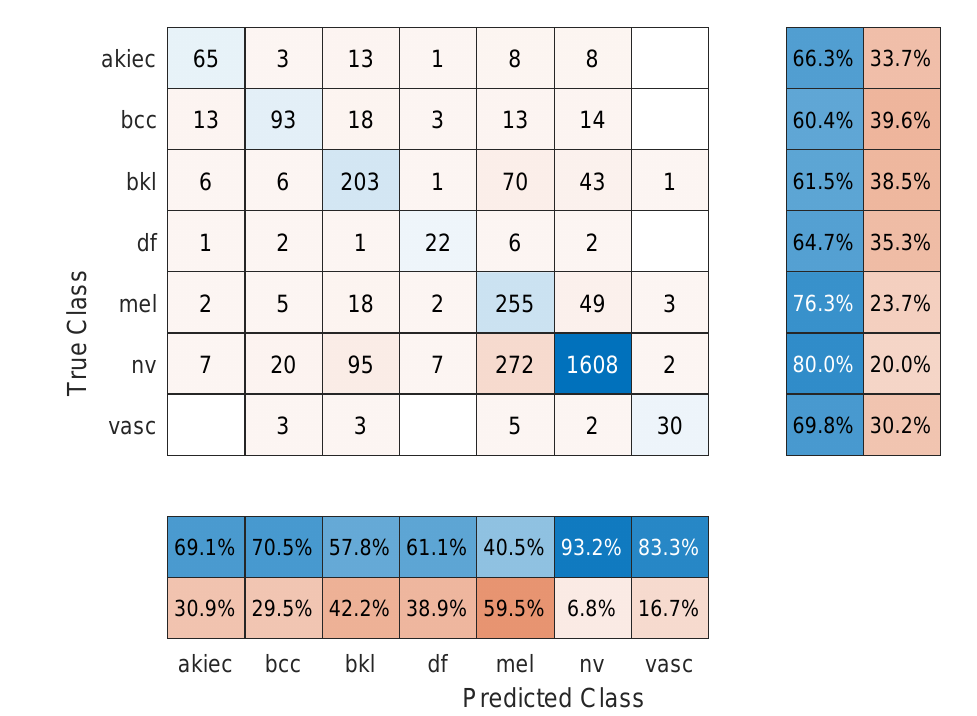
Figure 8. Sample confusion matrix for Resnet101 model, 70/30 data split and 50 epochs of training.